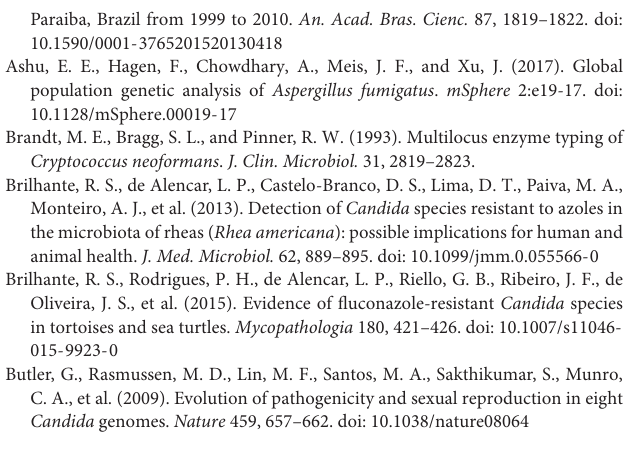
FIGURE S1 | Relationships among all 876 strains in the C. tropicalis MLST database as determined by their concatenated sequences at six gene fragments. For each strain, the strain name is followed by continent, country, and (when available) region (province/state/city). Scale bar represents the percent nucleotide base difference (0–12% on the scale bar) between strains, adjusted for diploids. TABLE S1 | Information about all 876 Candida tropicalis isolates analyzed in this study. Included in this table for each isolate are isolate name, geographic source, ecological niche, and multilocus genotype at six gene